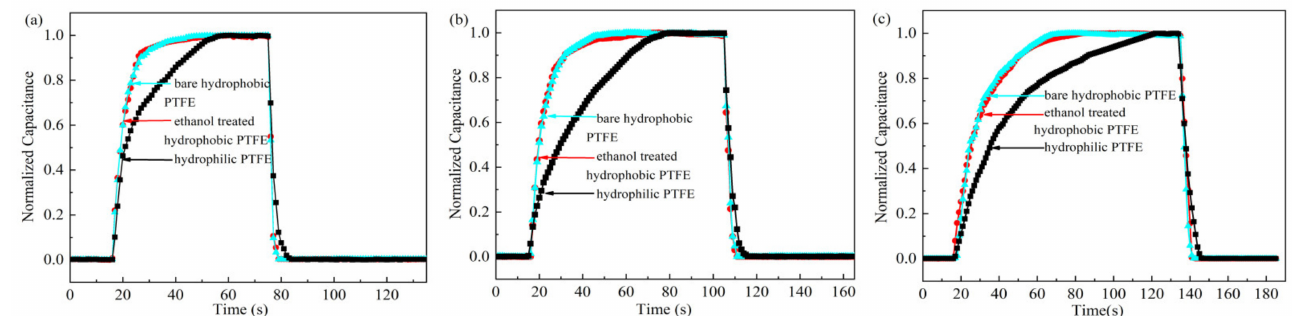
Figure 12. Response/recovery time of the sensors on different PTFE substrates (using N 2 ): ( a ) both sides are unsealed; ( b ) the backside is sealed; ( c ) the frontside is sealed.